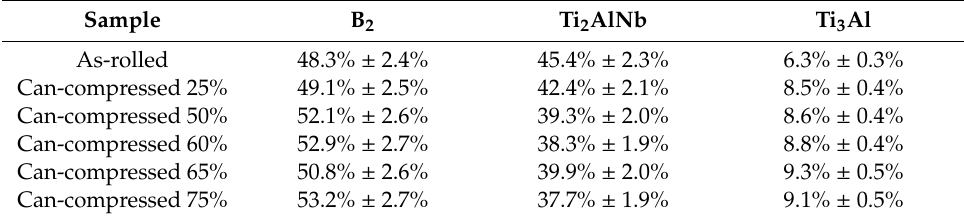
Figure 4. SEM images for the as-rolled and can-compressed samples subject to annealing treatment: ( a ) as-rolled, ( b ) 25%, ( c ) 50%, ( d ) 60%, ( e ) 65%, and ( f ) 75%. Table 2. Fractions of various phases in the annealing treatment Ti 2 AlNb alloy.